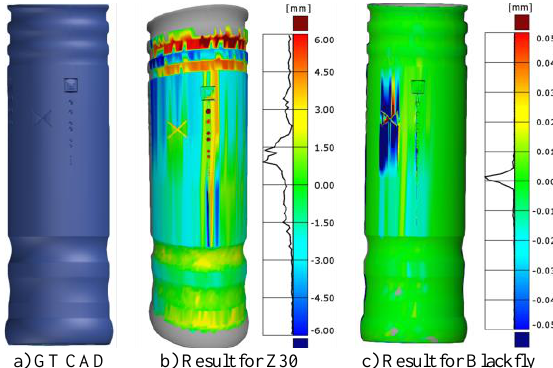
Figure 16. Deviation maps of the reconstructed riser to